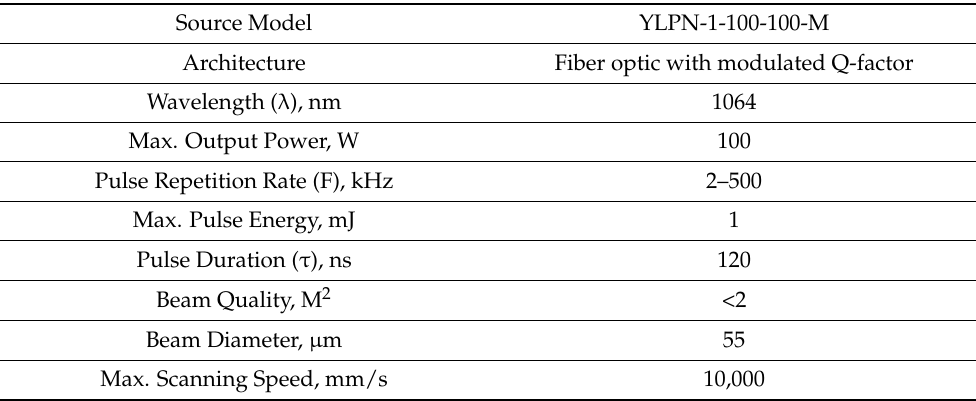
Table 2. General technical characteristics of the laser